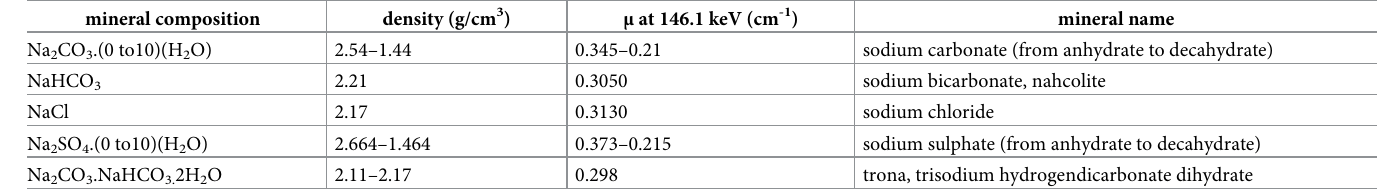
Table 2. Details and properties of the main constituting minerals of natron. mineral